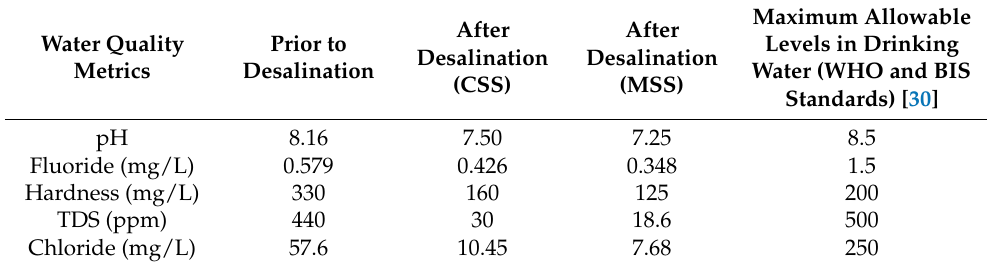
Table 4. Water quality